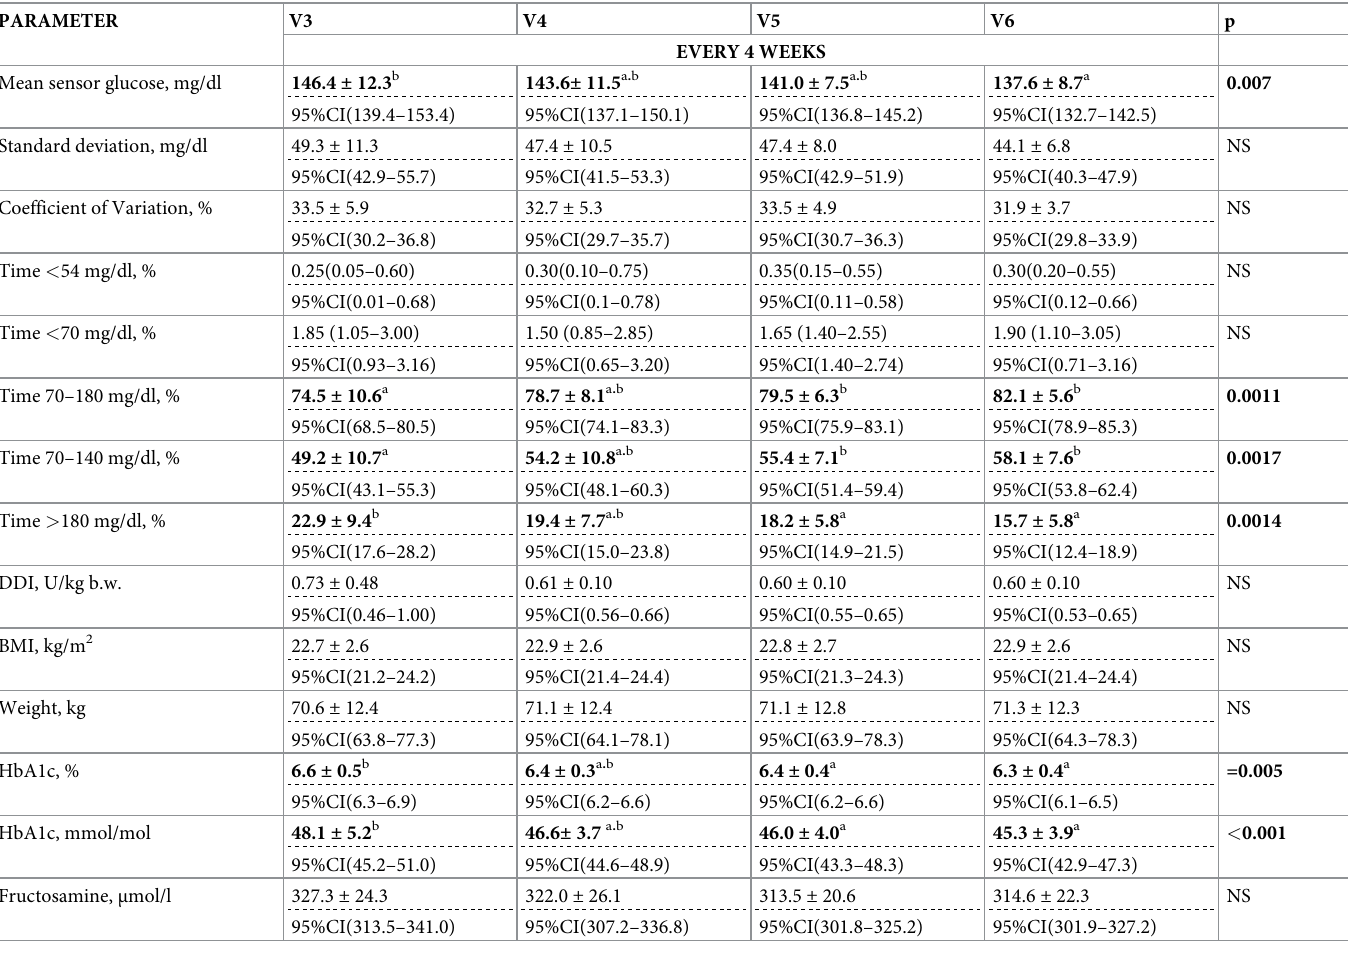
Table 3. Comparison of glycemic outcomes and insulin requirement on intermittent visits during study